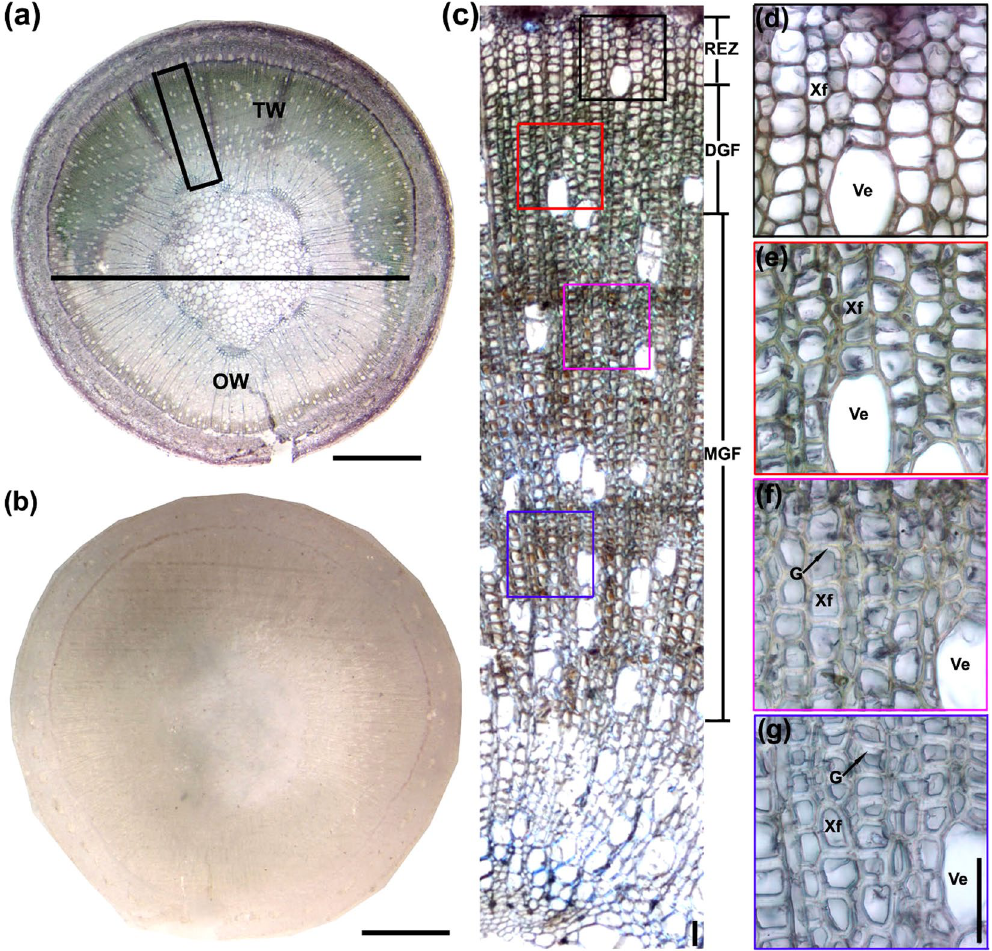
Figure 2. Immunohistochemical analysis of PtFLA6 during TW formation. ( a , b ) Cross-sections of the bended stems of the wild type poplar plants were hybridized with anti-PtFLA6 antibodies ( a ) or pre-immune IgG as control ( b ). Green-brown signals of PtFLA6 were specifically detected in the TW. The horizontal line indicates the division between TW side and OW side. TW, tension wood; OW, opposite wood. Scale bar = 1 mm. ( c ) A higher magnification of the framed area in ( a ). REZ, radial expansion zone; DGF, differentiating G-fiber; MGF, mature G-fiber. ( d – g ) Higher magnification images of the framed areas in ( c ). PtFLA6 accumulation was decreased as the G-fiber maturing. Ve, vessel cell; Xf, xylem fiber cell. Scale bars = 25 μ